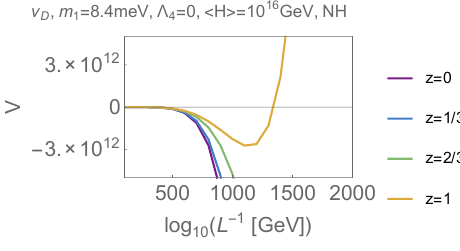
Figure 8 . The potential of the S 1 compacti(cid:12)cation of the SM where (cid:3) 4 = 0 and h H i = 10 16 GeV around the neutrino mass scale with NH. Here the scale L 0 is taken to be 1 GeV (cid:0) 1 . The potential is same as upper right panel of (cid:12)gure 7, but the vertical axis is the potential V itself, and the horizon axis is the small segment of L (cid:0) 1 around the neutrino mass scale.